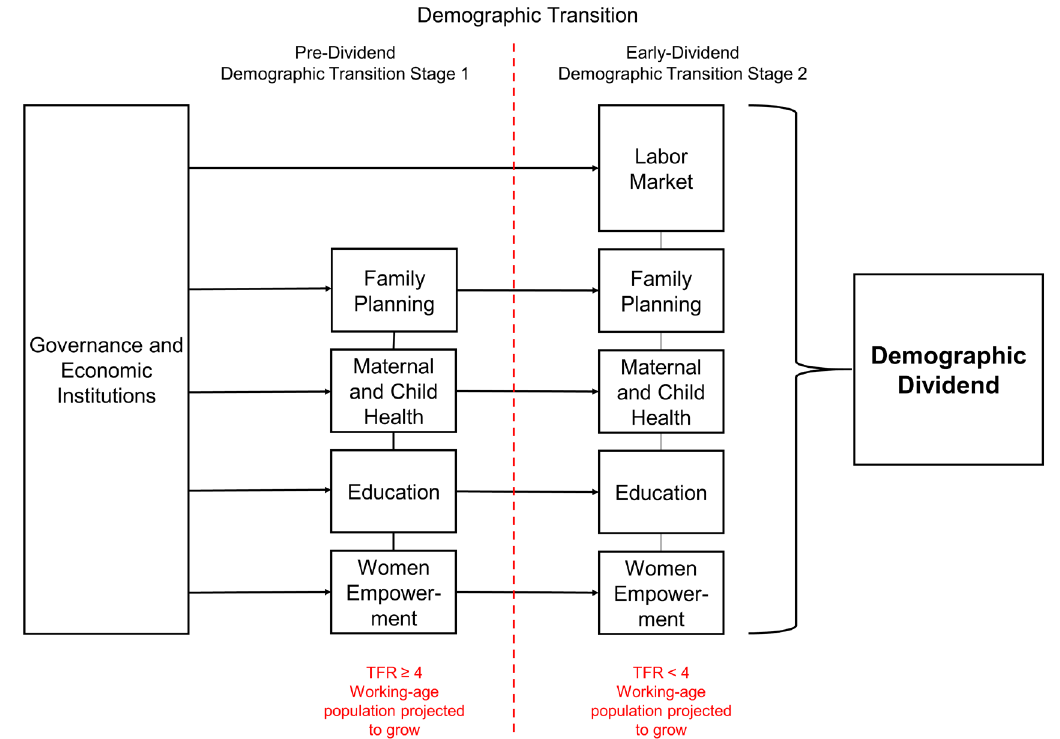
Figure 2. A demographic dividend